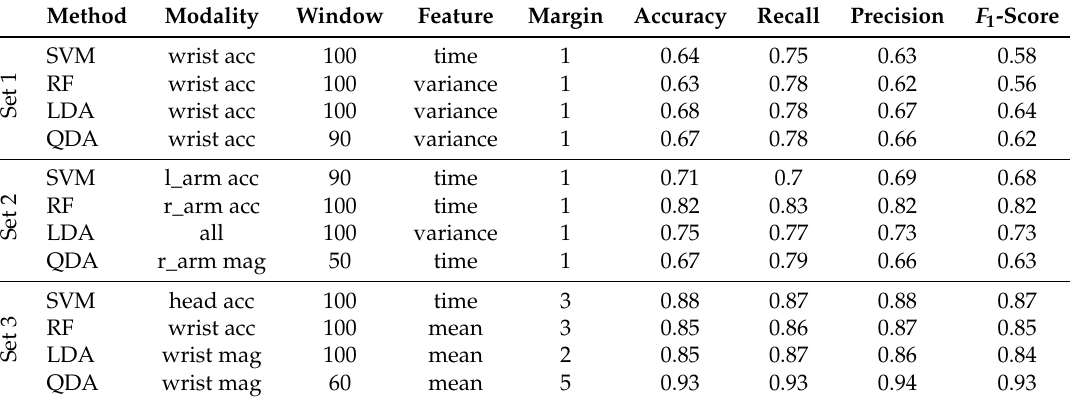
Table 2. Results for individual top experiment runs (by recall), per dataset for supervised methods, via the presented binary transition scoring (the feature extraction window is the number of samples (@50Hz); the extracted feature is mean, variance or time (time = mean/var/range/median); the transition scoring margin is the number of samples) (datasets numbered as listed in Section 4).